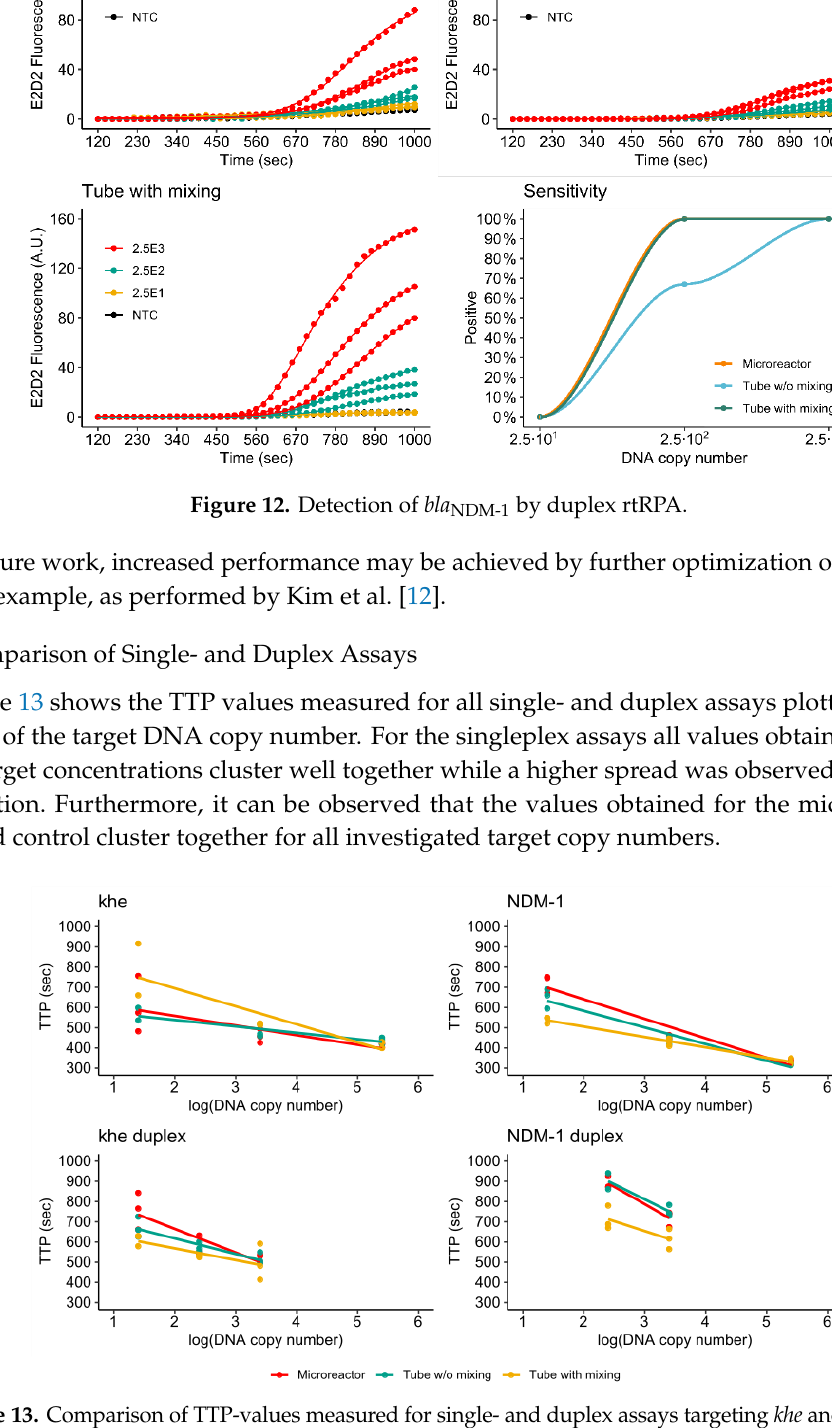
Figure 11. Detection of khe by duplex rtRPA.